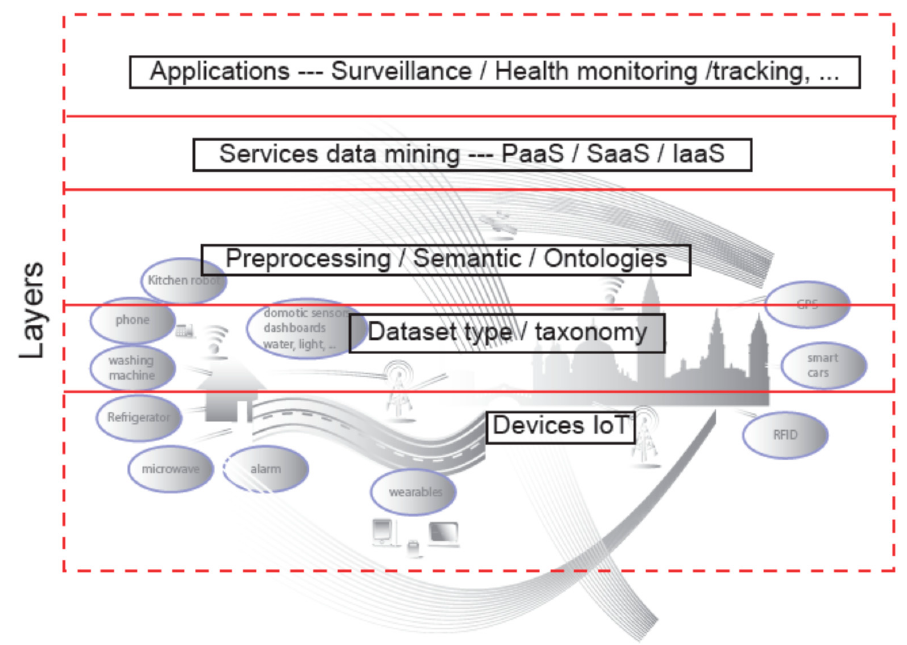
Figure 3. Overall architecture for IoT deployments and Applications.